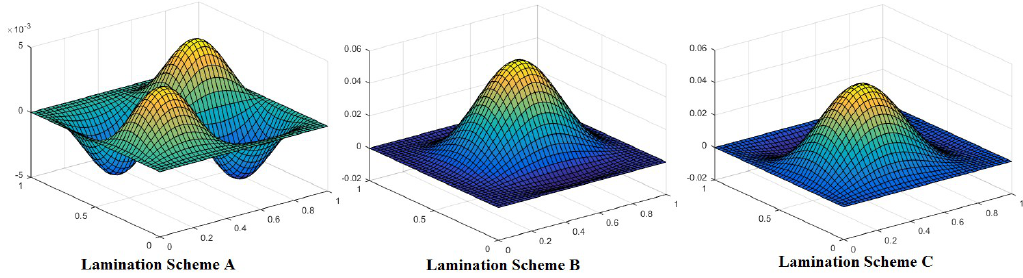
Figure 5. Mode shape for laminated composite plates with a / h = 20, M = 1, N x / N y = 2, N xy = 2 and CCCC boundary condition.